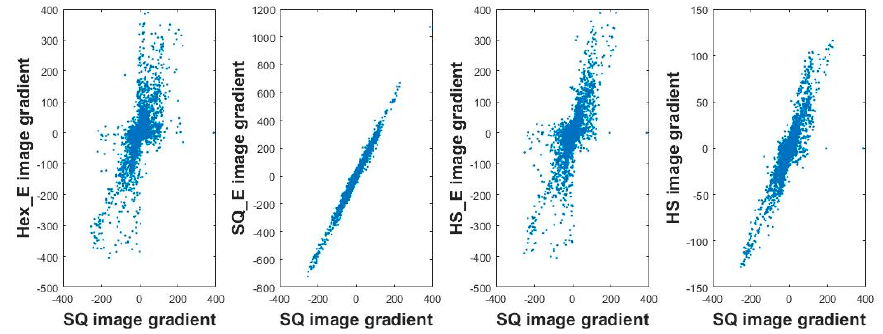
Figure 7. The gradient cross comparison at 0 degree between one of the original images and its generated images: Hex_E image (first), SQ_E image (second), HS_E image (third), and HS image (fourth).